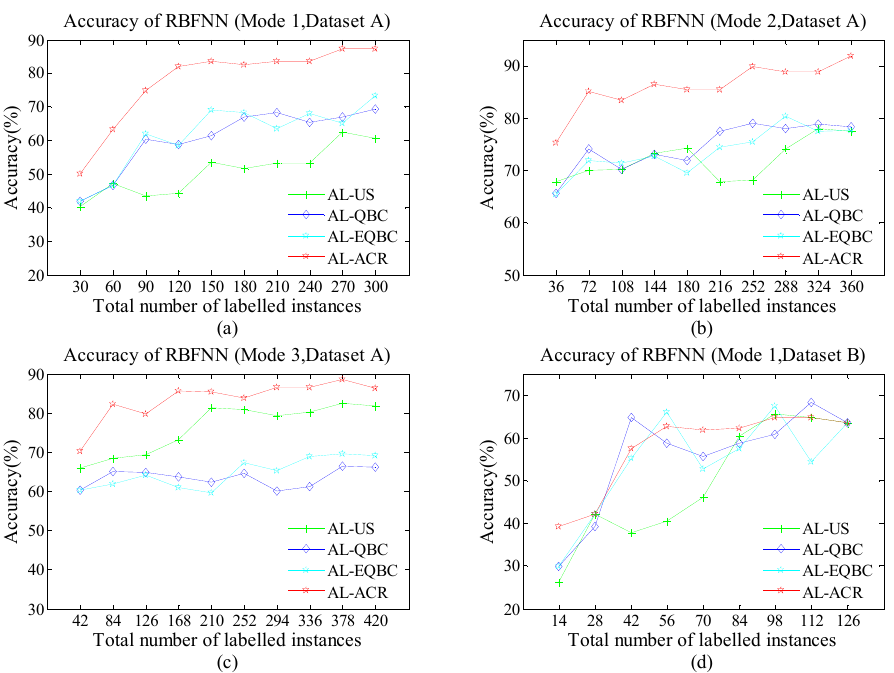
Figure 6. ( a ) Accuracy of radial basis function neural network (RBFNN) (Scenario 1); ( b ) Accuracy of RBFNN (Scenario 2); ( c ) Accuracy of RBFNN (Scenario 3); ( d ) Accuracy of RBFNN (Scenario 4).